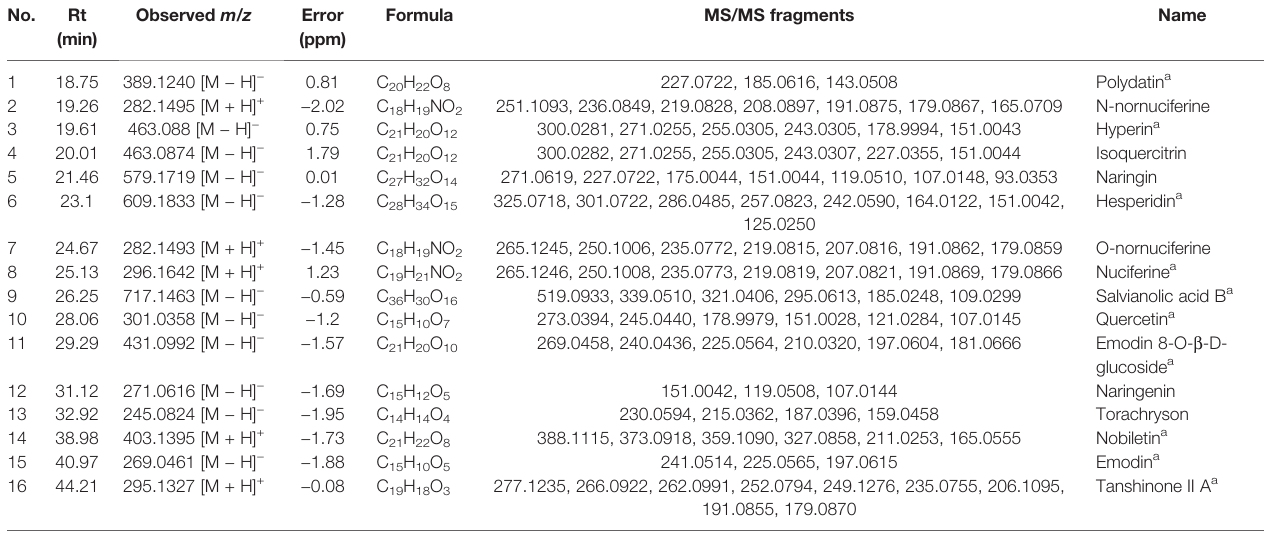
TABLE 3 | The compounds identi fi ed in hamster serum after oral administration of DHG.